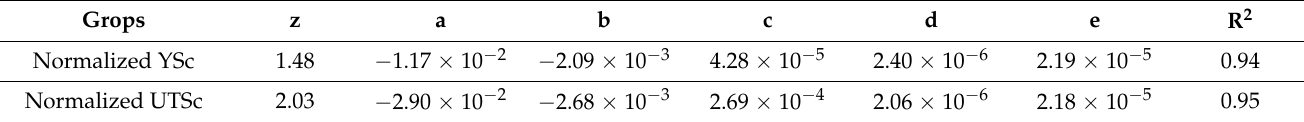
Table 2. Fitting results of the relation of normalized strength with the matrix strength and the particle size. Grops z a b c d e R 2 Normalized YSc 1.48 Normalized UTSc